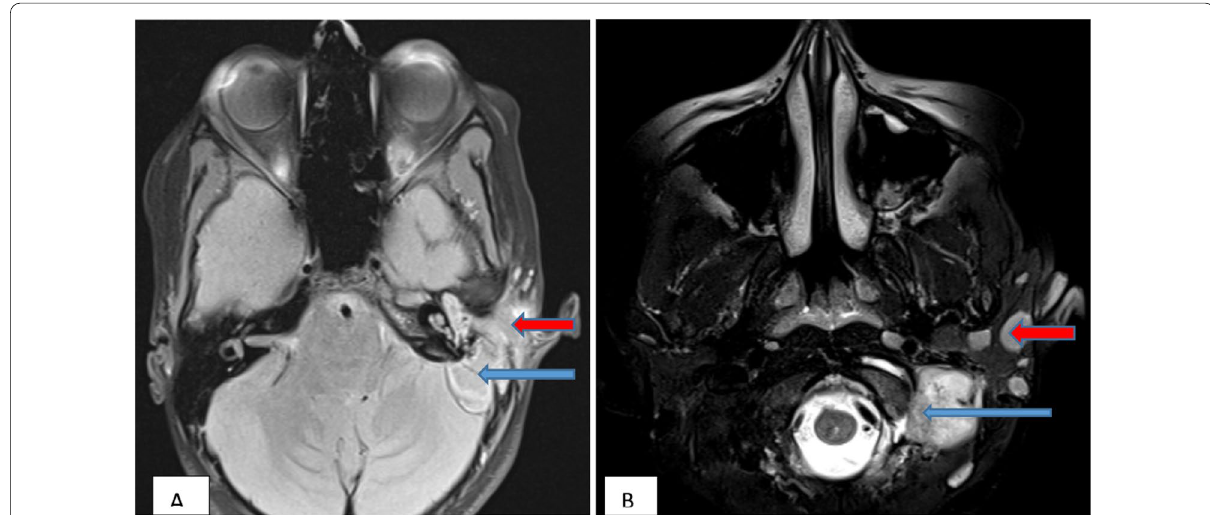
Fig. 2 Axial sections of MR image at base of skull shows: A ) T1 fat-suppressed image: T1 hypo-intense soft tissue lesion in left external auditory canal (red arrow); extension of soft tissue along left cerebellopontine angle and indenting left cerebellar hemisphere (blue arrow). B ) T2 fat-suppressed image: Prominent left intraparotid lymph nodes (red arrow) with T2 hyper-intense soft tissue lesion in the left occipital condyle (blue